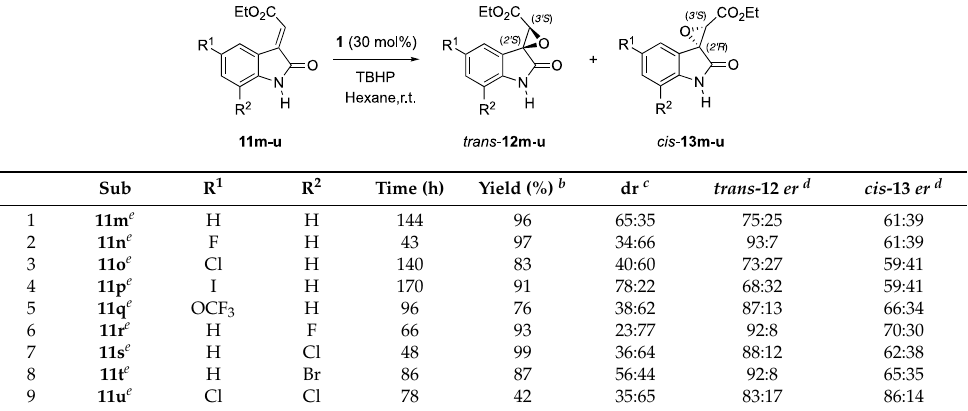
Table 3. Substrate scope of the organocatalytic epoxidation of α -ylideneoxindoles 11m – u featured with N -unprotected amide a .